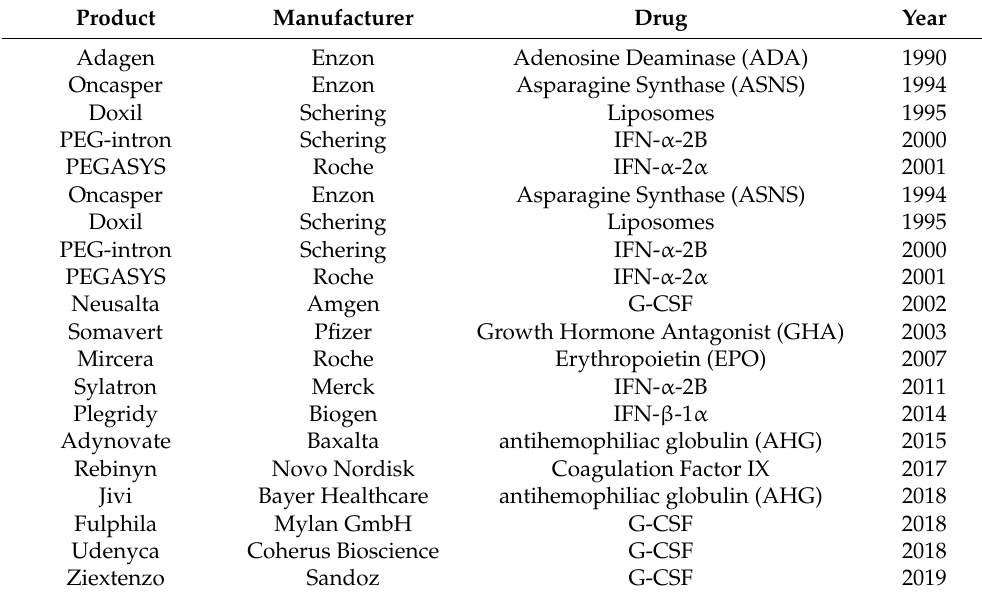
Table 1. The PEGylated drugs on the market in recent